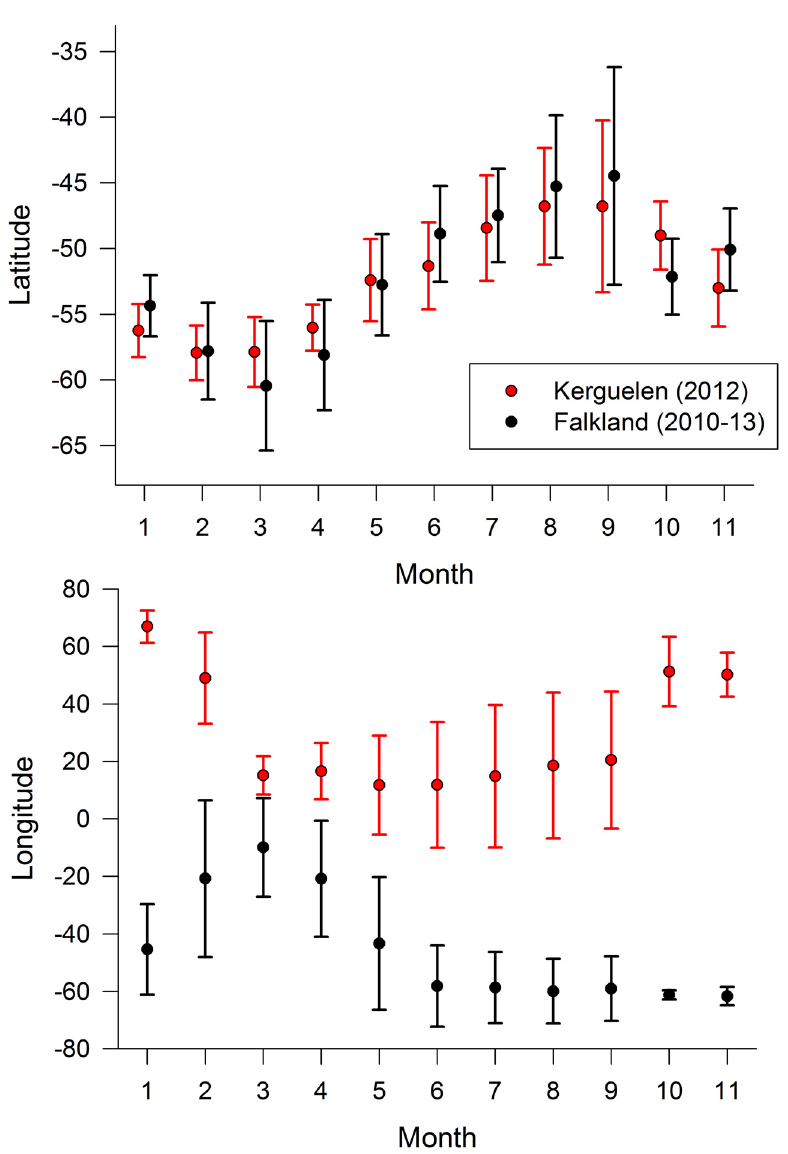
Fig 2. Year-round movements of thin-billed prions from the Falkland and Kerguelen Islands. Mean ( ± SD) latitudinal and longitudinal positions of thin-billed prions from the Falkland and Kerguelen Islands over the